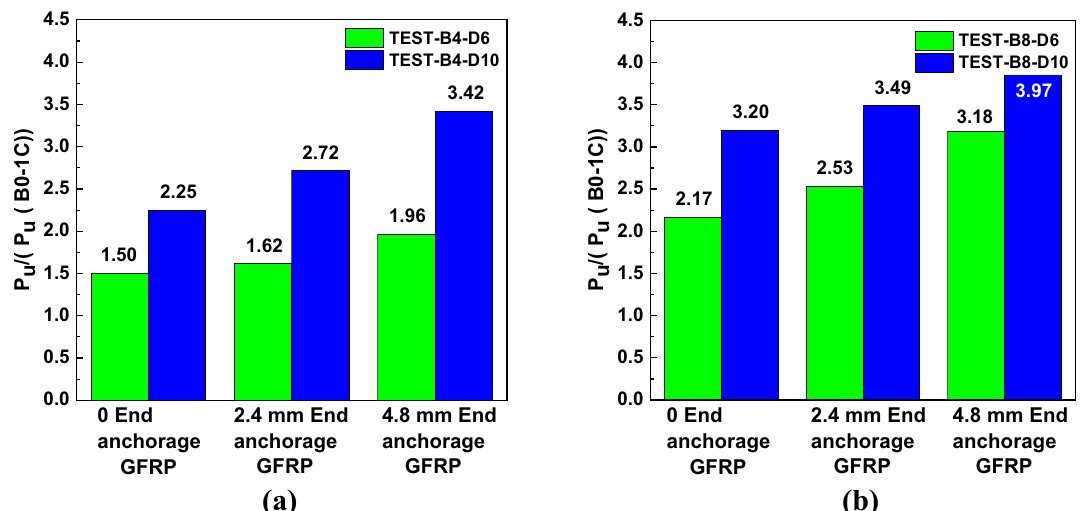
Fig. 12 Normalized ultimate load versus bolt diameter and end-anchorage